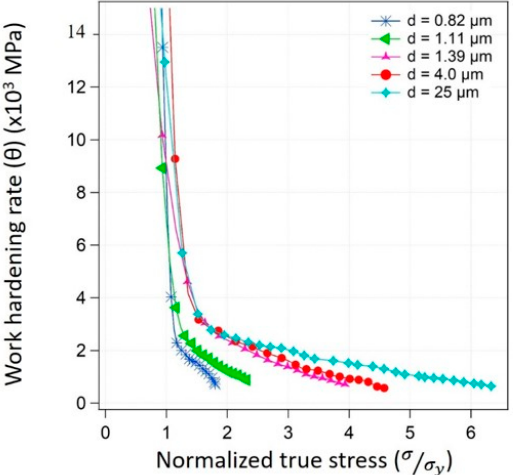
(cid:17) (cid:16) d σ ), determined from tensile testing to failure (cid:4673) ), determined from tensile testing to fail- d ε (cid:3031)(cid:3084)